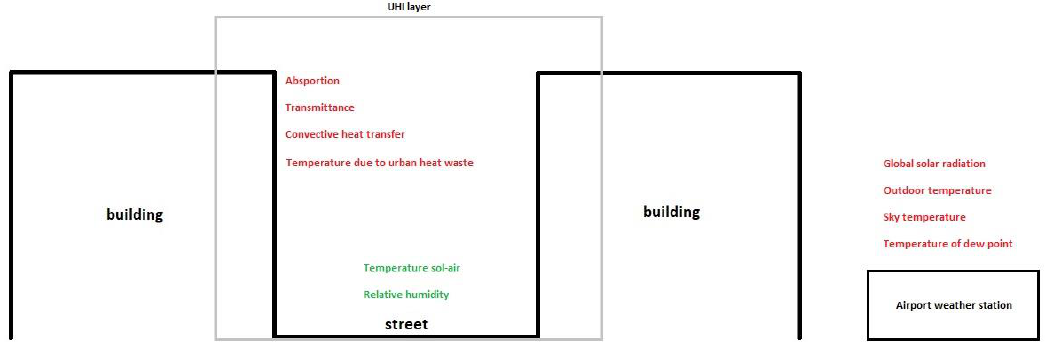
Figure 7. Geometry and boundary conditions of the urban layout for the comparison analysis.